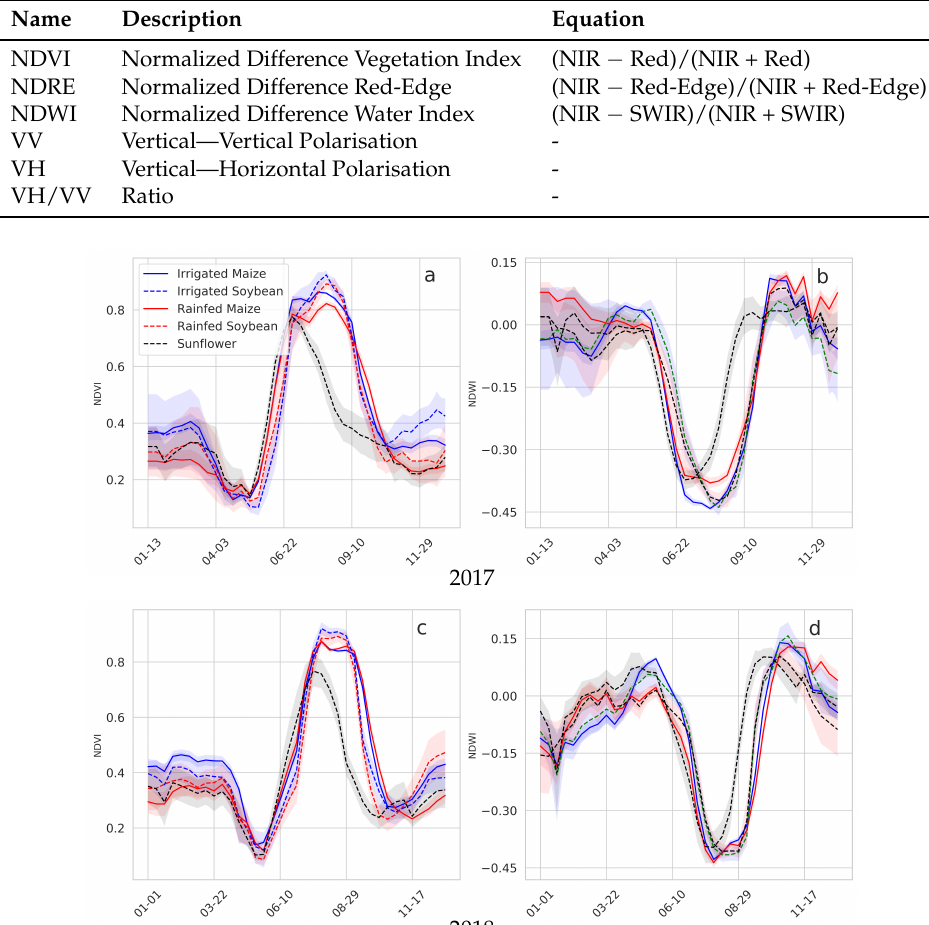
Figure 3. Dynamics of optical indices (Normalized Difference Vegetation Index (NDVI) ( a , c ) and Normalized Difference Water Index (NDWI) ( b , d )) for maize, soybean and sunflower crops. The solid line curves represent maize, the dotted line represents soybean, with irrigated blue and rainfed red for both crops. The black curve represents sunflower. The envelope around the curves corresponds to the 95% confidence